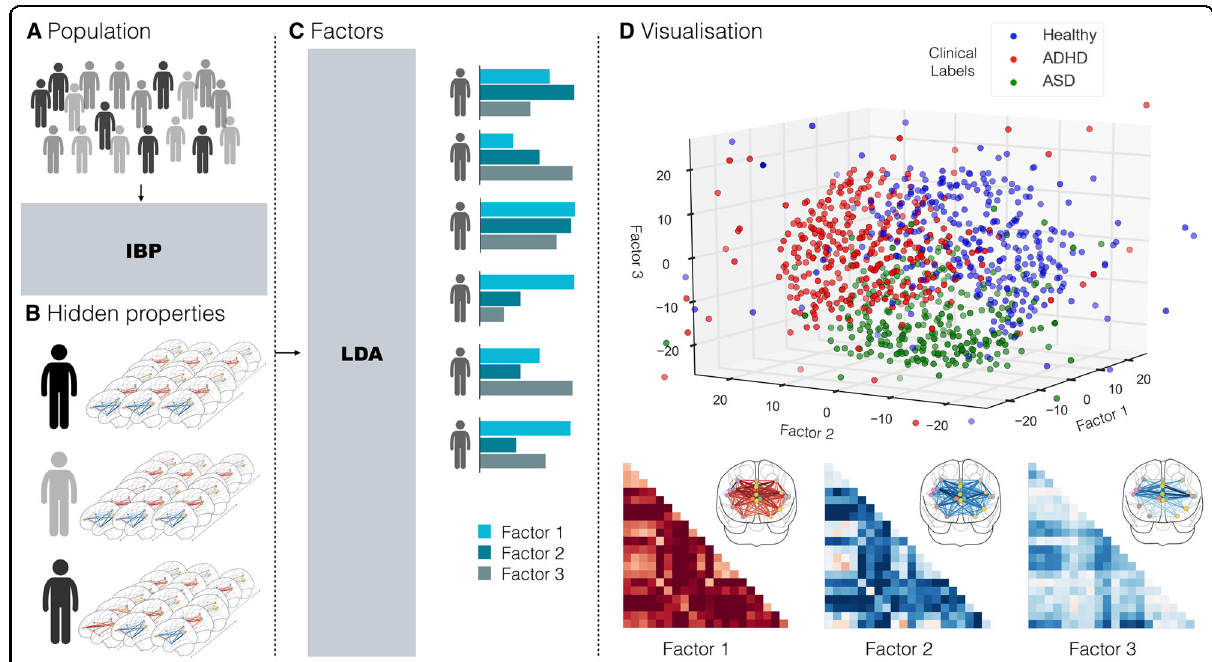
Fig. 2 Work fl ow. a DMN, DAN, an SN network coupling was studied in a composite sample of 1,305 TD, ADHD, and ASD individuals taken from two multisite open-data repositories (ADHD-200 and ABIDE). b In a data-driven fashion, Indian Buffet Processes (IBP) automatically derived the number of hidden properties in the connectional fi ngerprints across participants without recourse to their clinical status. Automatic detection and weighing of shared and distinct unknown biological causes prompts its use in the identi fi cation of endo-phenotypes. c Latent Dirichlet Allocation (LDA) then inferred three overarching factors of underlying brain variation. Importantly, LDA allowed to derive hidden variability factors with mixed membership. Therefore, each participant ’ s connectional fi ngerprint was modeled to be simultaneously caused by multiple implicit neurobiological factors. d Each individual composition of the three neurobiological factors (representing distinct network-coupling pro fi les, lower section ) was related to their respective clinical diagnoses (TD, ADHD, and ASD). In a preliminary analysis based on t-distributed stochastic neighbor embedding (t-SNE; ref. 62 ), biological subtypes can be identi fi ed from network connectivity patterns that are partly shared across TD, ADHD, and